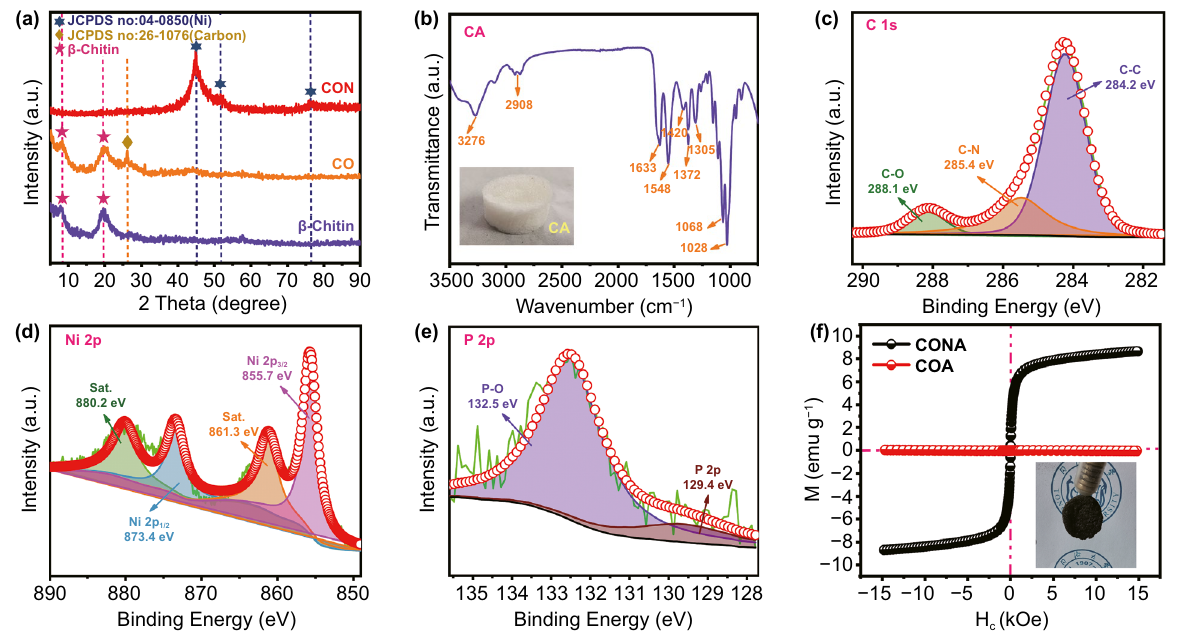
Fig. 2 a XRD patterns of samples; b FTIR spectra of CA; high-resolution XPS survey: c C 1s, d Ni 2p, and e Ni 2p; f room-temperature hyster- esis loops of COA and